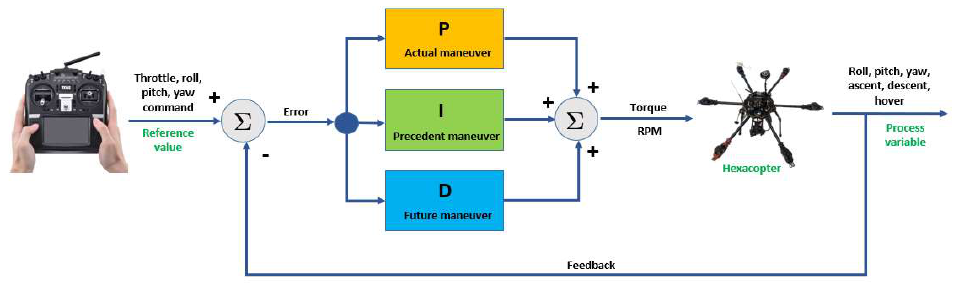
Figure 24. Closed-loop PID scheme—general approach.